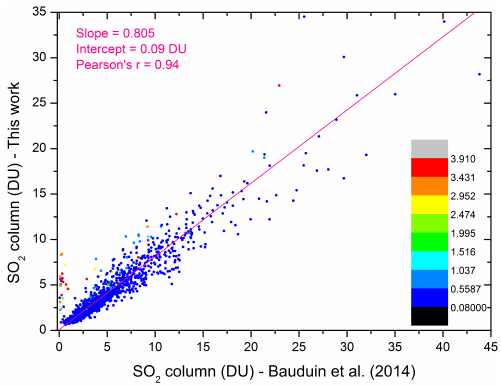
Figure 10. Comparison between SO 2 columns retrieved above the industrial area of Norilsk using the retrieval method developed in this work and the 0–5km SO 2 columns retrieved in Bauduin et al. (2014). Measurements located within a radius of 150km centred in Norilsk with less than 25% cloud coverage and retrieved with rela- tive errors smaller than 25% and absolute errors smaller than 10DU have been taken into account. Furthermore, only measurements with a H 2 O amount at 350m lower than 4gkg − 1 and with thermal con- trast larger than 5K in absolute value have been considered (see detailed explanations in the text). The pink line corresponds to the linear regression (reduced major axis) calculated between the two sets of data. The colour bar represents the humidity at 350m ex- pressed in gkg − 1